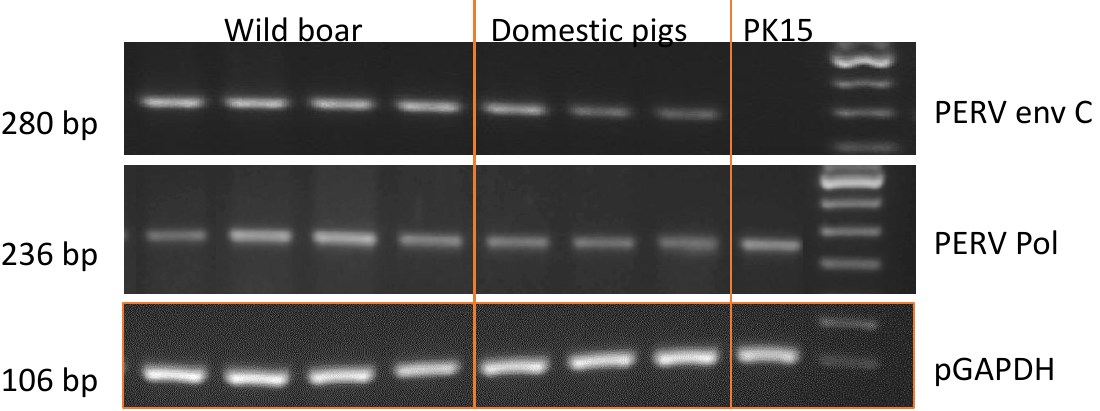
Figure 4. Results of the PCR specific for PERV-C and pol region of PERV (PERVpol) of DNA from wild boars and domestic pigs (German landrace). PK15 cells were used as control and the length of the amplicons is indicated.